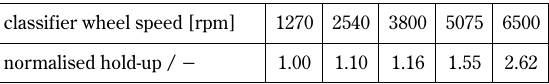
Table 3 Hold-up as a function of the classifier wheel speed